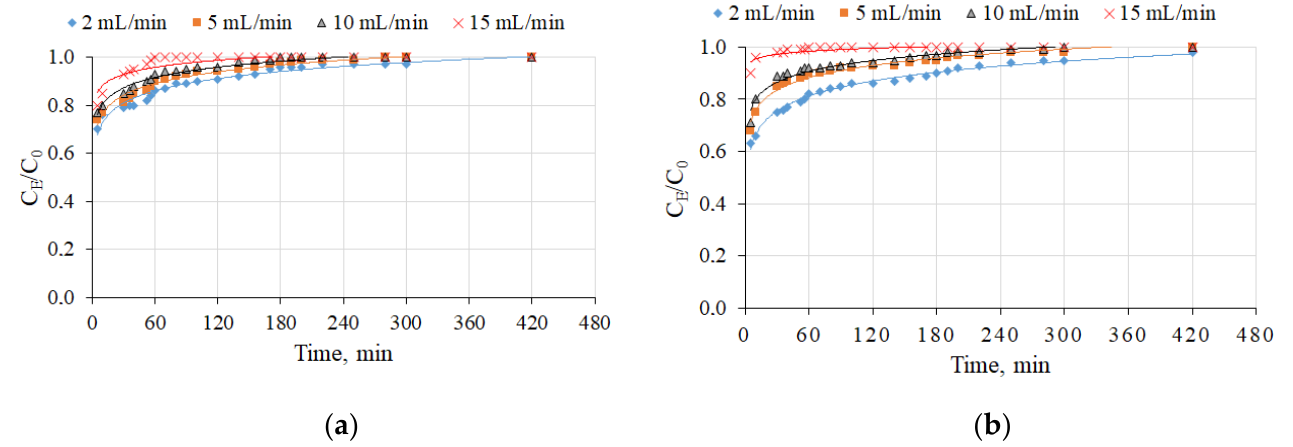
Figure 4. Influence of the flow rate on the breakthrough curves of NH 4+ ion sorption by straetlingite-based sorbents (S20 and S30) in wastewater from an open recirculation African catfish farming system: ( a ) S20(according to the Table 1); ( b ) S30. The initial NH 4+ ion concentration in the synthetic aqueous solution was 10 mg/L and the filtration rates were 2, 5, 10, and 15 mL/min. Table 2. The influence of filtration rate on the breakthrough point time (min) and NH 4+ sorption capacity (mg/g).